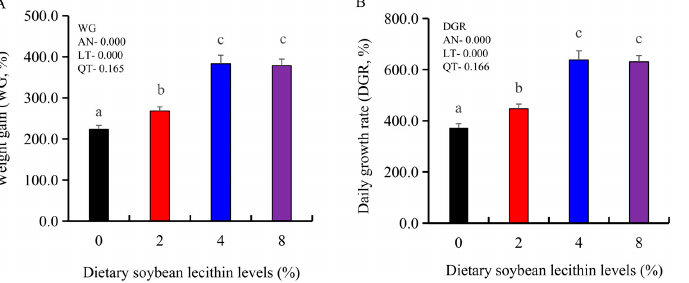
Figure 1. Effect of dietary soybean lecithin on weight gain (%) ( A ) and daily growth rate (%) ( B ) of juvenile largemouth bass. Bars with different letters indicate significant differences ( p < 0.05), while that with the same letter or no letter superscripts indicate no significant differences ( p > 0.05), AN: ANOVA, LT: linear trend, QT: quadratic trend.